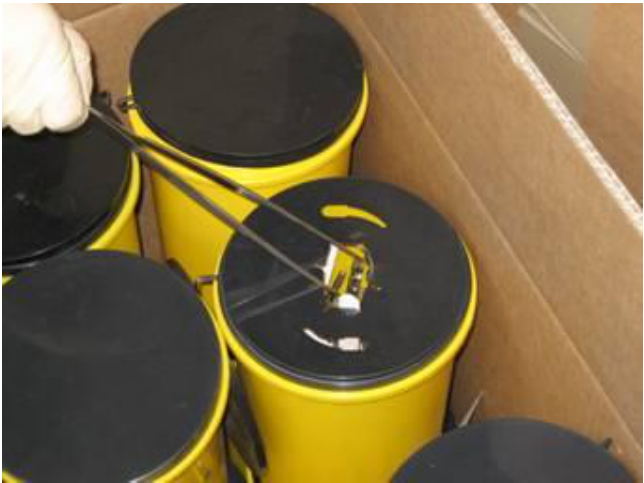
Figure 2. Incorrect segregation of waste documented in the Nuclear Medicine Service.